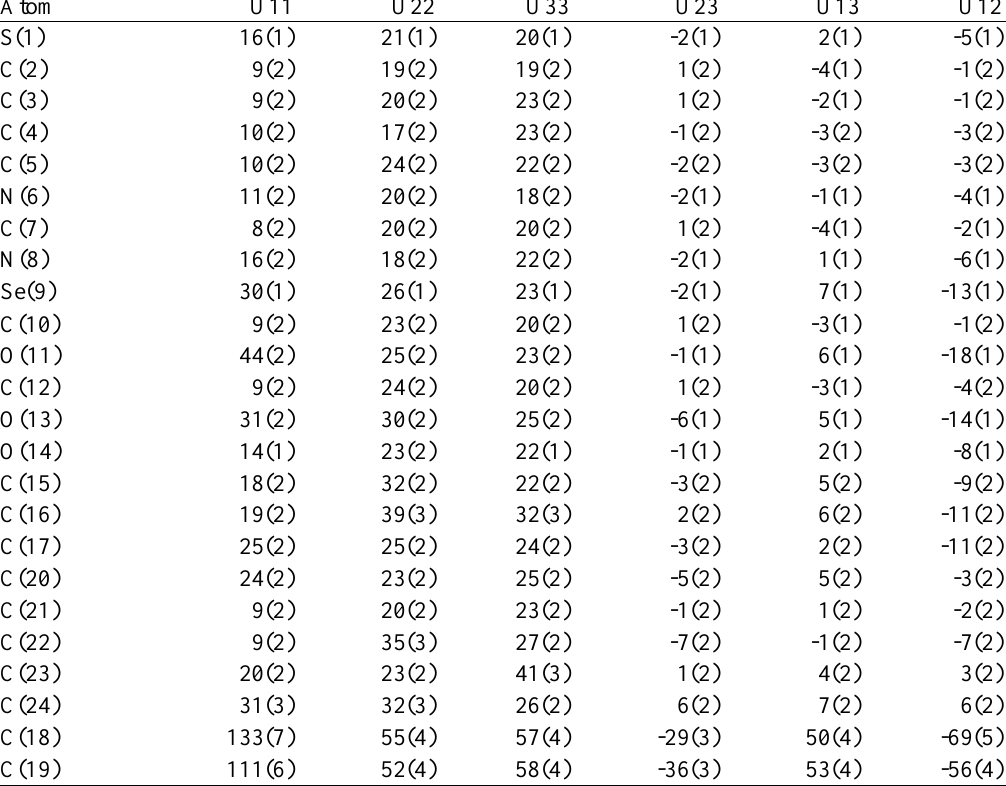
Table 7. Symmetry transformations used to generate equivalent atoms: anisotropy displacement